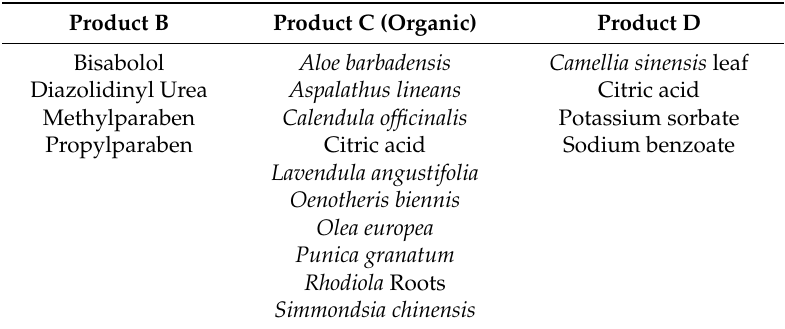
Table 1. Preservatives and ingredients with antimicrobial properties found in the eye creams from three different manufacturers (Products B, C, and D).